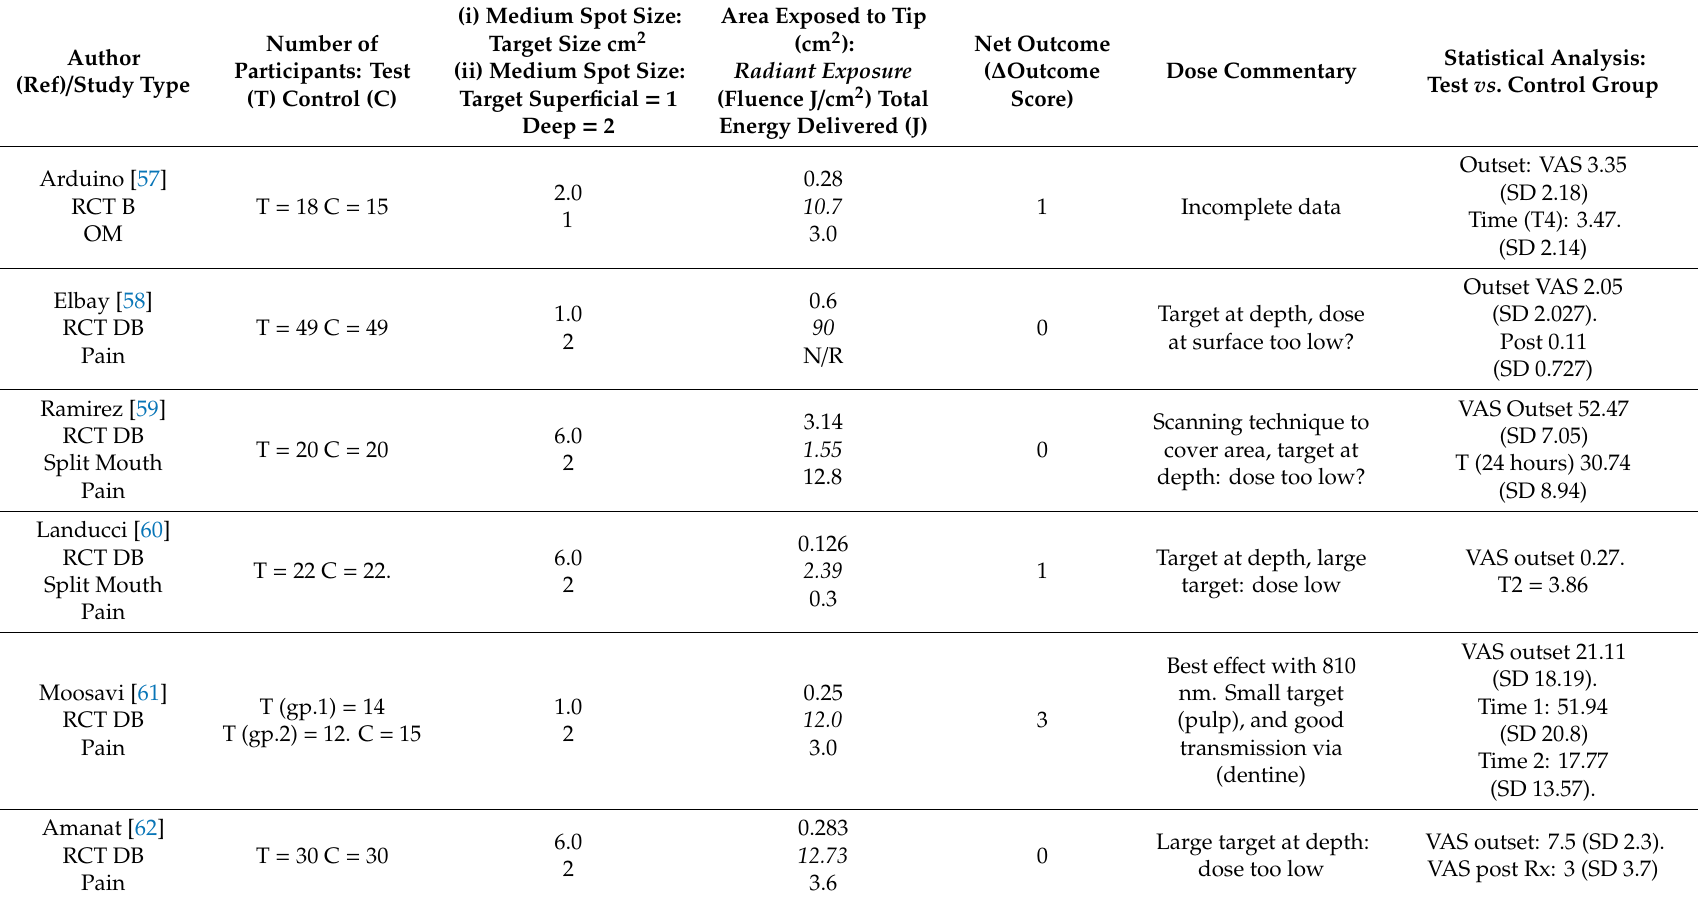
Table 3. Group B. Medium spot (0.126 to 0.38 cm 2 ) analysis of papers. Outcome key (0–5): 0 = null e ff ect; 1 = 10–20%; 2 = 20–40%; and 3 = 40–60%; 4 =